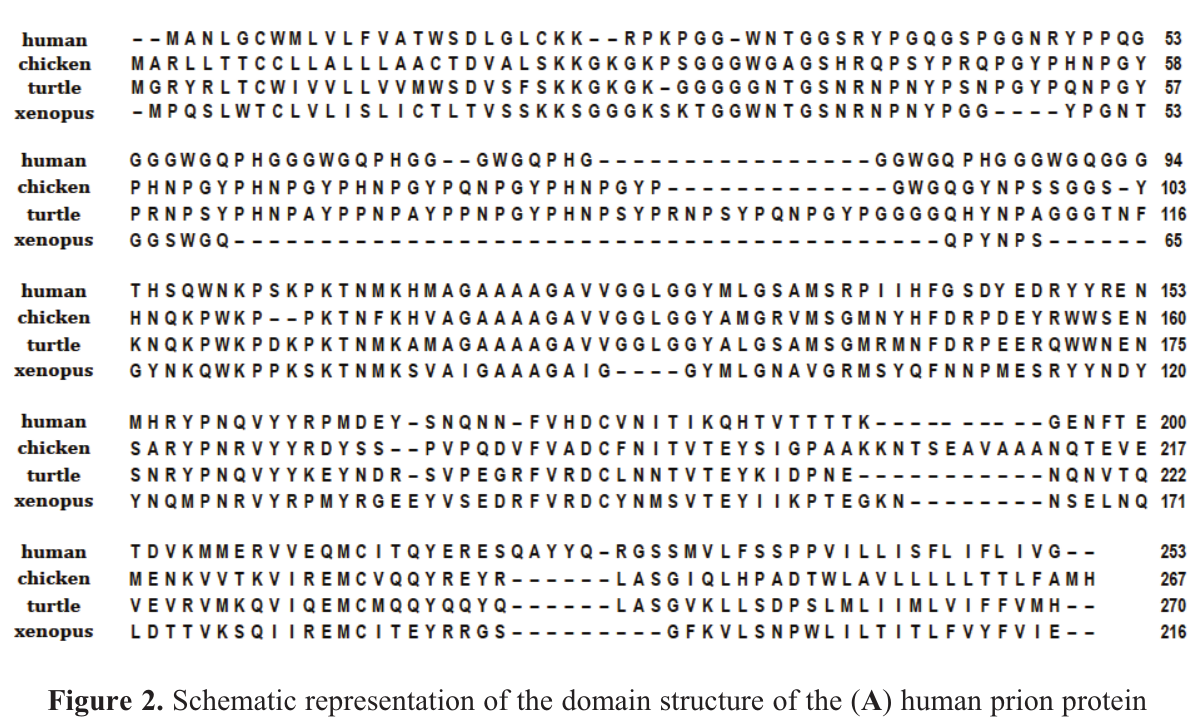
Figure 1. Sequence alignment of different species’ prion proteins.